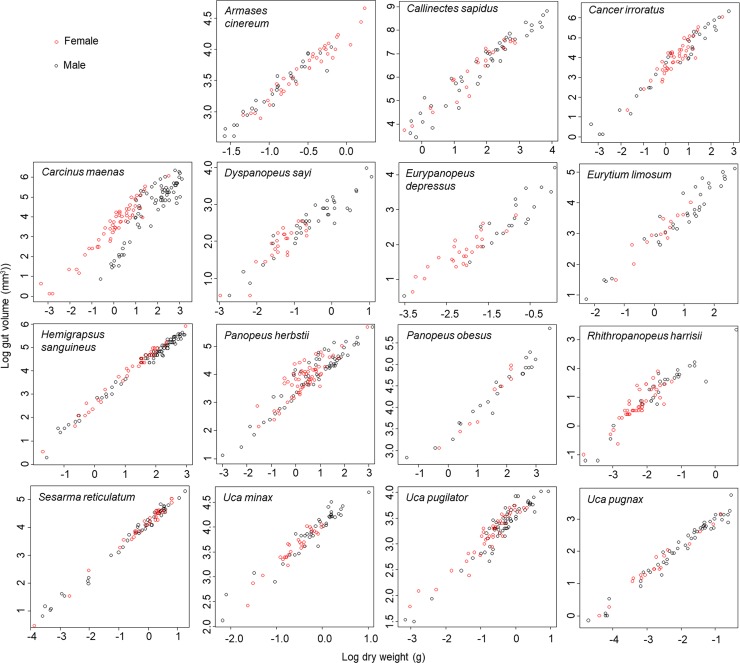
Log stomach volume (mm3) as a function of log dry body mass (g) for 15 species of brachyuran crab.Black circles are male and red are female.